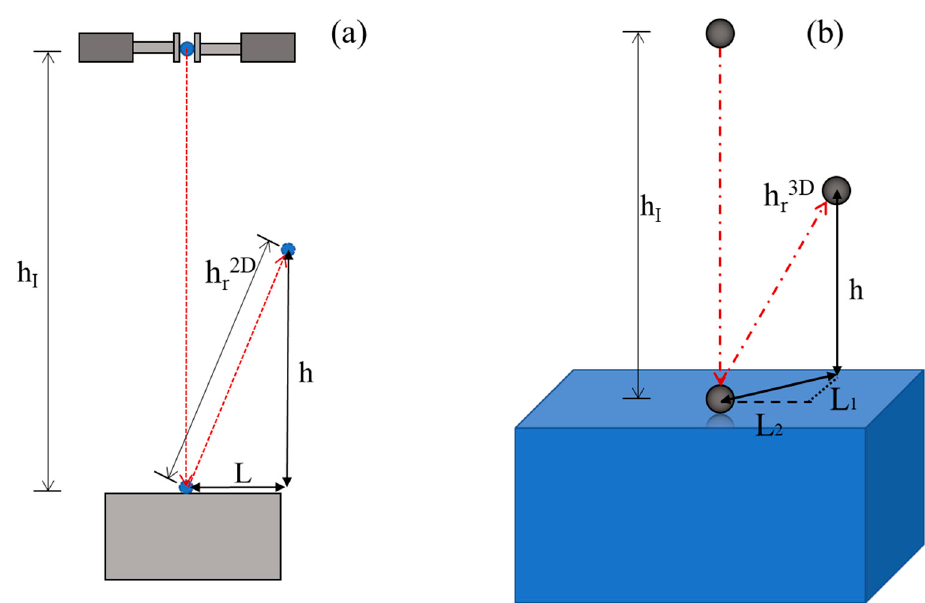
Figure 7. Schematic illustration of the estimation of the rebound height: ( a ) 2D illustration and ( b ) 3D illustration for oblique rebounds (red dotted lines along with arrows indicate dropping and rebounding paths).